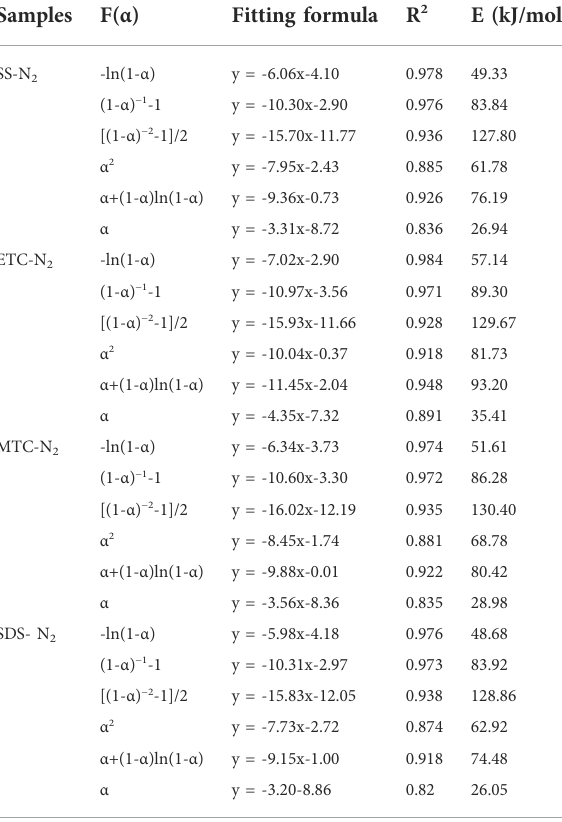
TABLE4CombustionkineticparametersofdifferentSSsamplesbased on Coats-Redfern